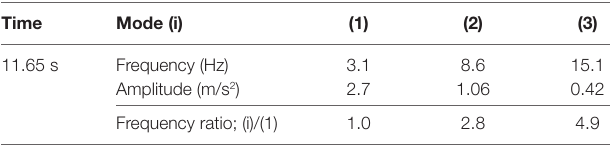
Table 5 | Dominant frequency in acceleration amplitude